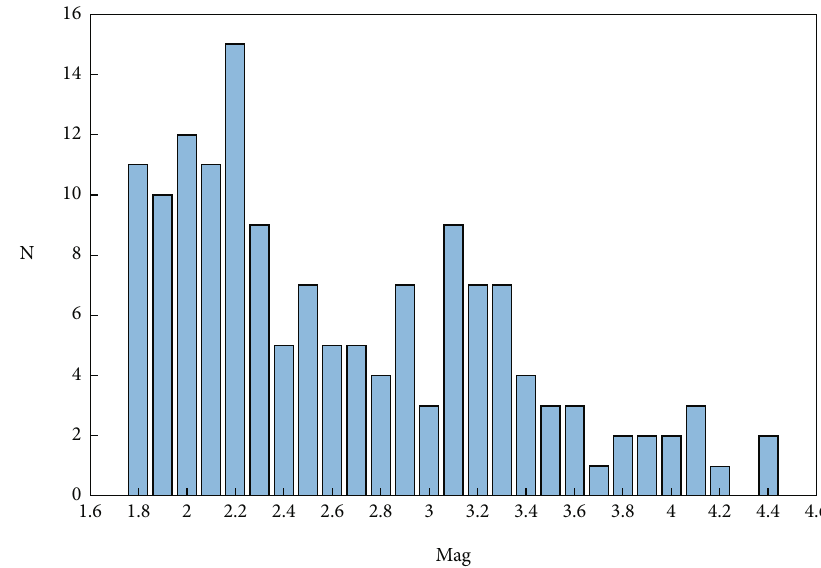
Figure 3: Frequency distribution of earthquakes versus local magnitudes.